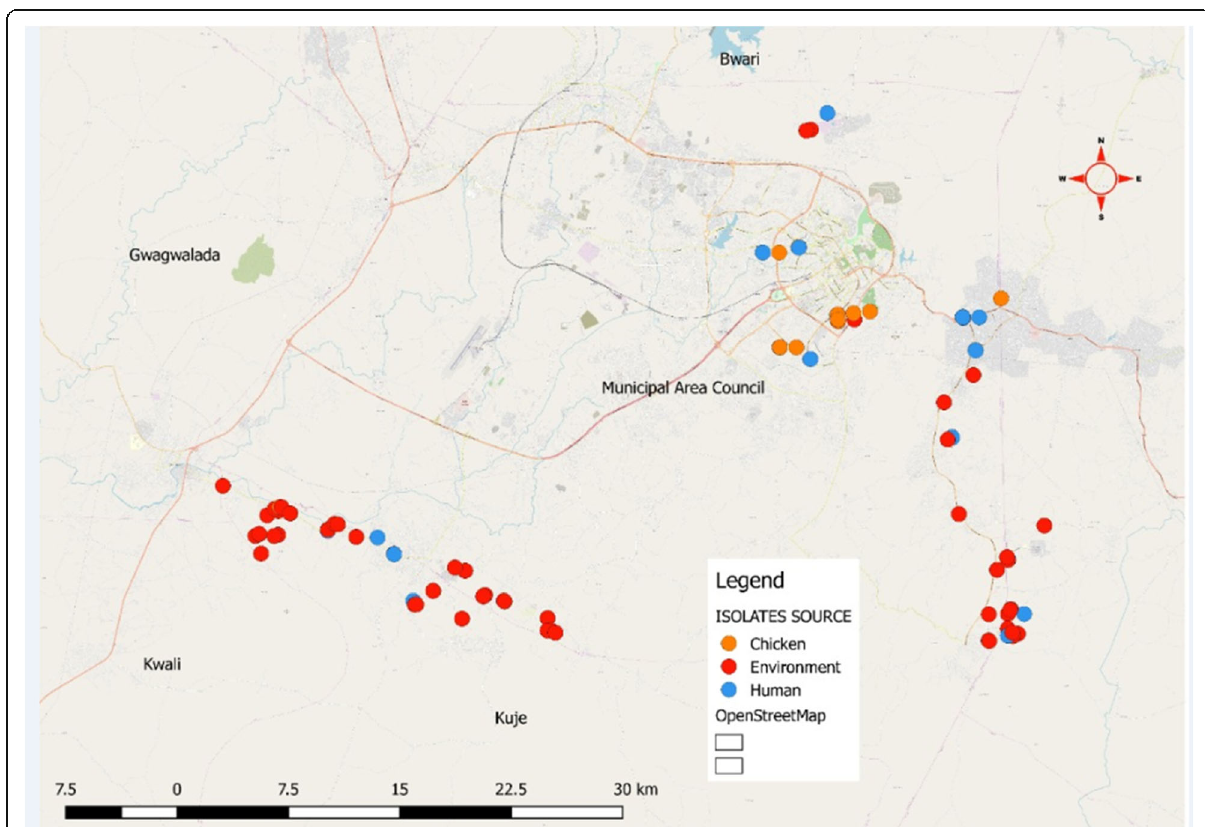
Fig. 1 Map of Abuja showing the distribution of ESBL-EC human, chicken and environmental isolates from farms and chicken markets. This map highlights five out of six area councils in Abuja, Federal Capital Territory namely: Bwari, Kwali, Kuje, Gwagwalada and Municipal area councils. Our study was done at two area councils (Kuje and Municipal area councils) with the highest volume of poultry production in Abuja. Each dot represents an ESBL-EC isolate obtained either from humans, chickens or the environment (Source of the Map is the Federal Ministry of Agriculture and Rural Development, Abuja,